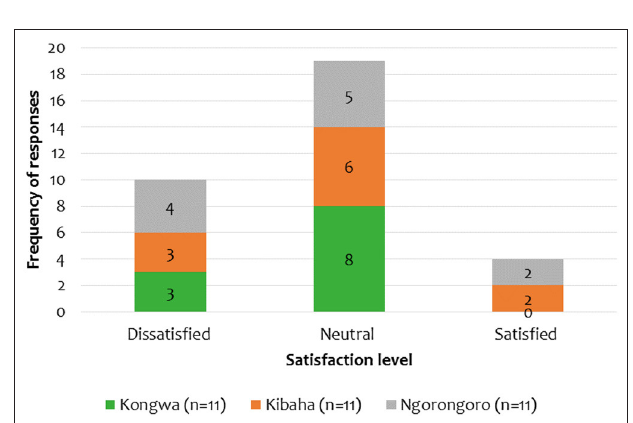
FIGURE 7 | Satisfaction level of the respondents to the current surveillance